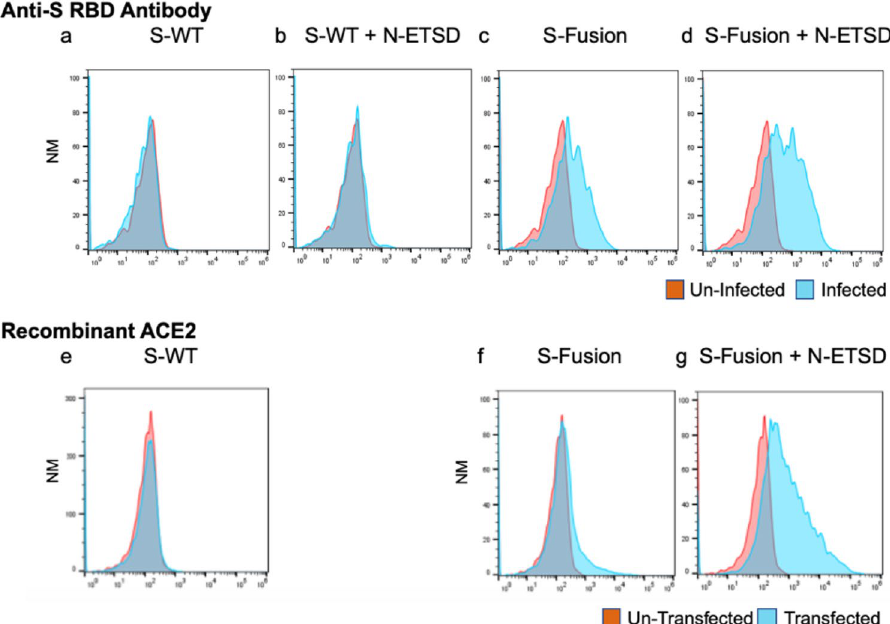
Figure 1. HEK‑293T cells expressing hAd5 S‑Fusion + ETSD show enhanced spike receptor binding domain (S RBD)‑specific antibody and recombinant ACE2 (rACE2) binding. Flow cytometric analysis of anti-S RBD antibody binding to construct-infected cells reveals surface expression of S RBD is very low in ( a ) S-WT or ( b ) S-WT + N-ETSD infected cells and is higher in ( c ) S-Fusion infected cells. The highest S RBD cell surface expression was seen for ( d ) S-Fusion + N-ETSD infected cells. rACE2 showed little binding to HEK- 293T cells transfected with ( e ) S-WT, higher binding with ( f ) S-Fusion, and the highest binding with ( g ) S-Fusion + N-ETSD. Y-axis scale is normalized to mode